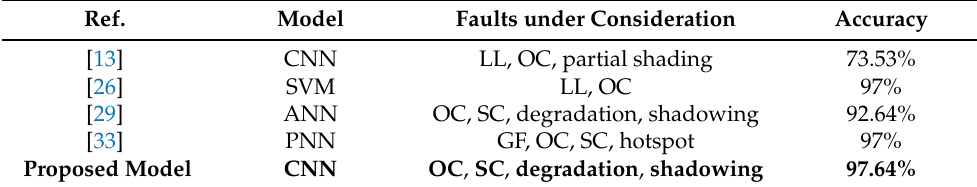
Table 1. Accuracy comparison of our model with previous